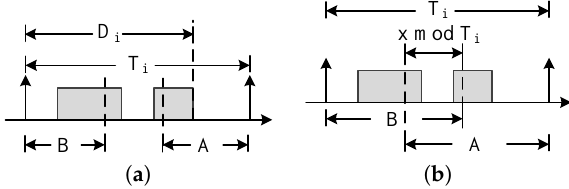
Figure 4. Computation of W CI